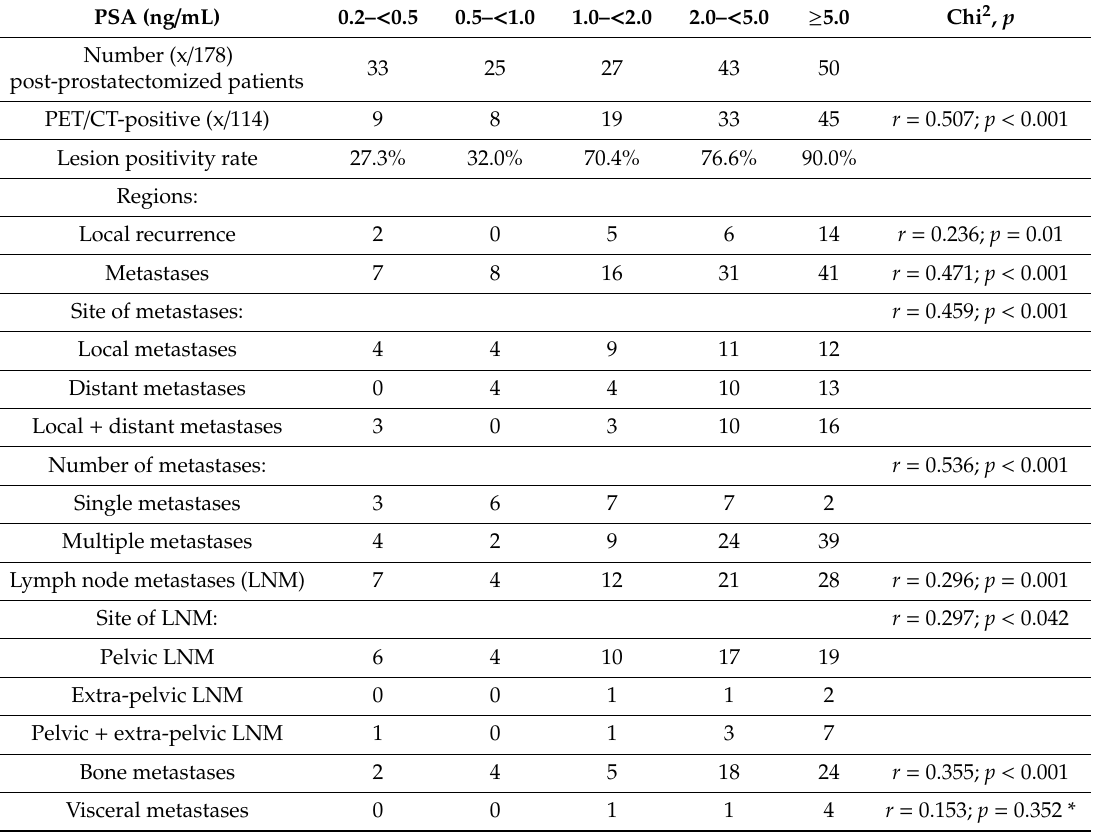
Table 2. PET / CT findings: Lesion positivity rate (LPR) post-prostatectomized (P-P) related to di ff erent PSA